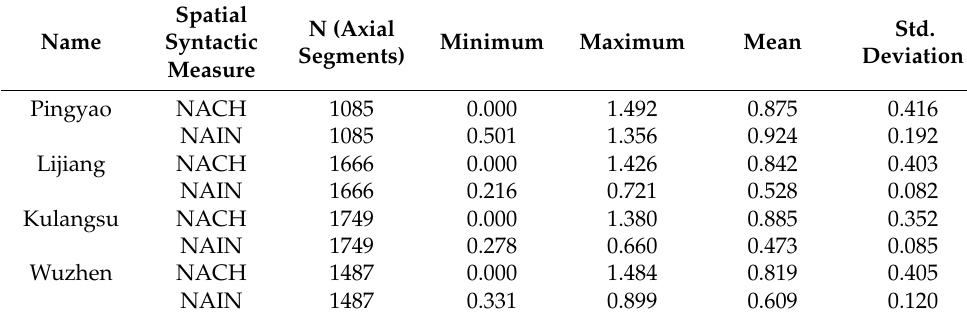
Table 3. The NACH and NAIN values of street networks in the four HCTs.